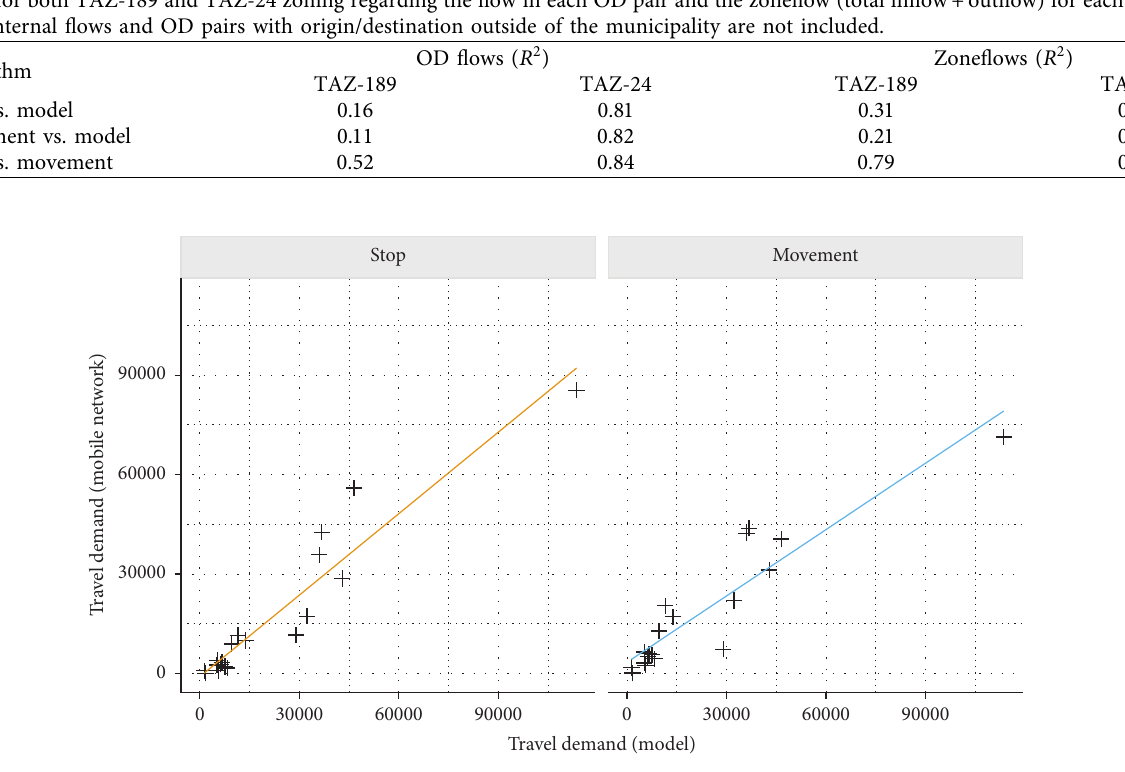
MOVEMENT algorithm.